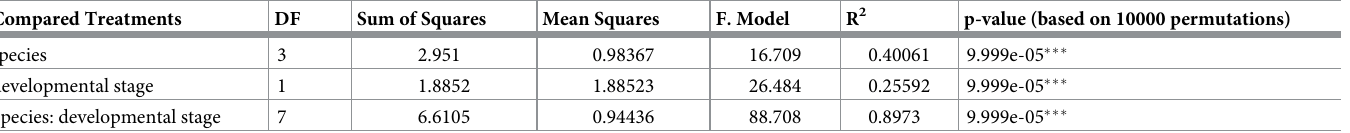
Table 2. Permutational multivariate analysis of variance using distance matrices to test for an effect of species, developmental stage and their interaction on CHC profile composition. Compared Treatments